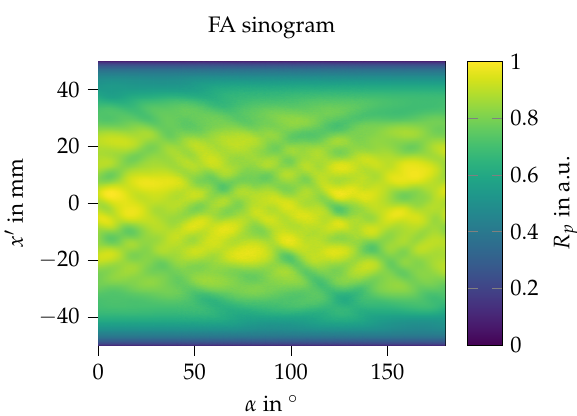
Figure 3. Full angle (FA) sinogram in angular range [ 0,180 ] ◦ . Mathematically, a sinogram is the forward operation of the Radon